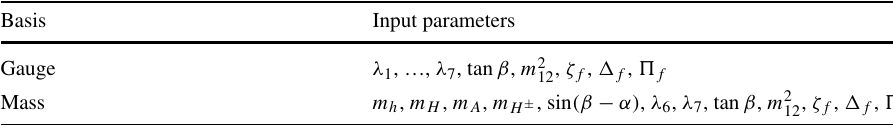
Table 2 2HDM input parameters for different basis ( f = u , d , l )